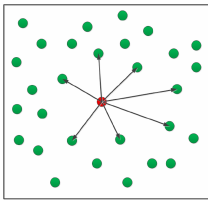
Figure 3. Topological